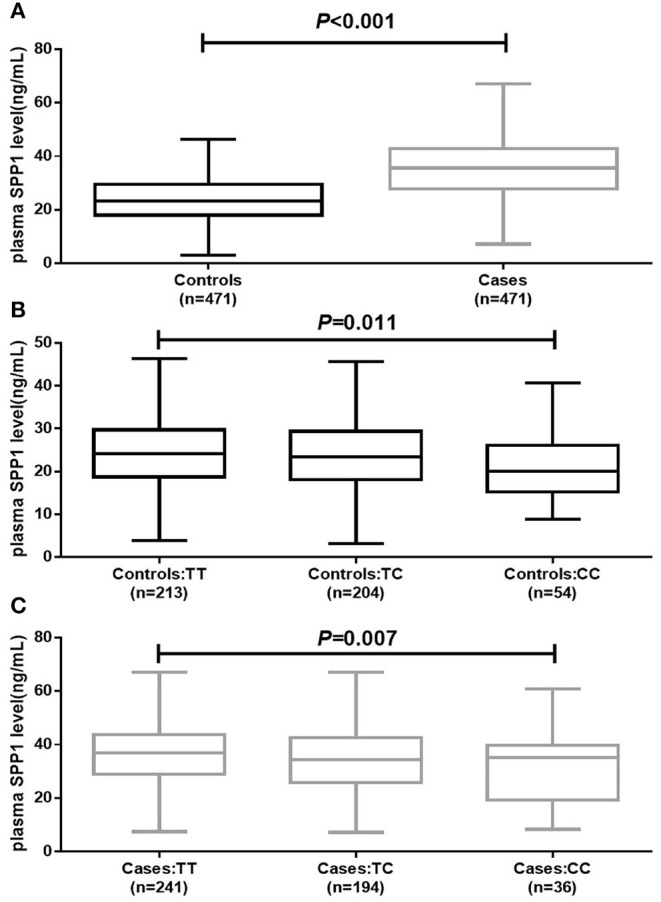
Plasma secreted phosphoprotein-1 (SPP1) level in controls and cases. (A) Decreased plasma SPP1 level was found in breast cancer (BRC) patients compared to controls (P < 0.001). (B) Decreased plasma SPP1 level was found in controls carrying the rs11730582 CC genotype compared with those carrying the rs11730582 TT (P = 0.011). (C) Decreased plasma SPP1 level was found in BRC patients carrying the rs11730582 CC genotype compared with those carrying the rs11730582 TT (P = 0.007). The upper and lower boundaries of the boxes represented the 25th and 75th percentiles of plasma SPP1 level value, and the horizontal line within the box represents the median value. All P-values were adjusted by age at diagnosis and age at menarche.